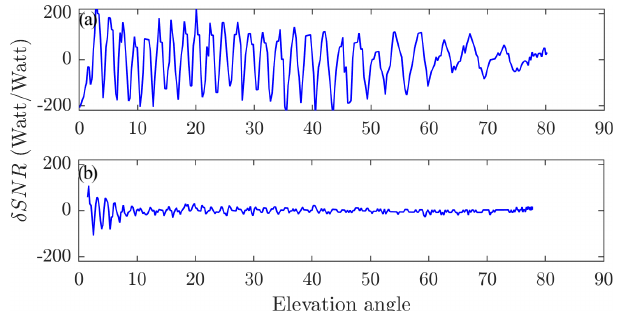
Figure 1. Examples of the interference pattern observed in de- trended SNR data as a function of satellite elevation angle for (a) one of the GNSS100L antennas used in this study placed approxi- mately 3m above a water surface and (b) a Leica AR25 antenna at site GTGU in Onsala, Sweden, situated approximately 4m above a water surface. The data for site GTGU are available online as part of the study Geremia-Nievinski et al. (2020). The oscillations in (b) are dampened with increasing elevation angle, whereas in (a) the oscillations have a constant